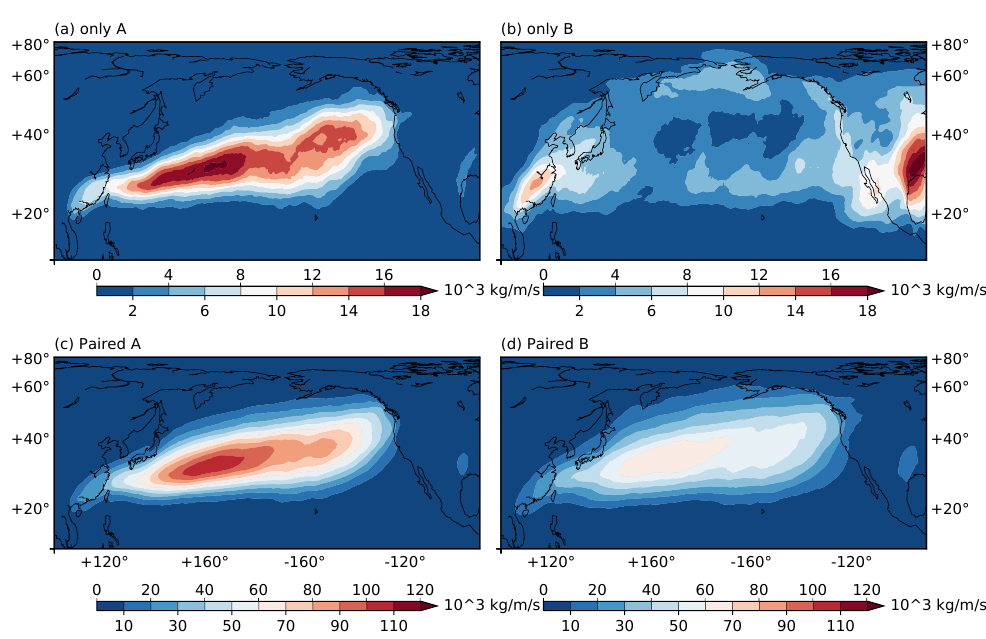
Figure 8. Similar as Figure 7 but for matchings between the THR and IVT85%